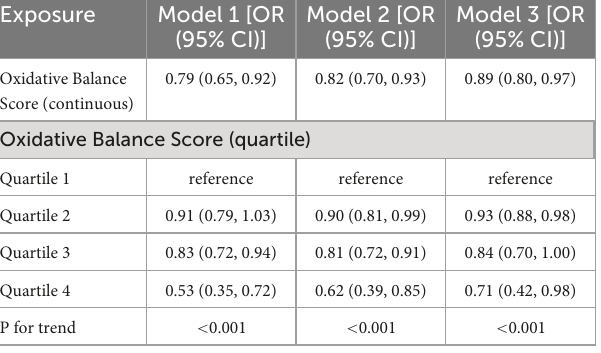
TABLE 3 The associations between Oxidative Balance Score and periodontitis. Exposure Model 1 [OR Model 2 [OR Model 3 [OR (95% CI)] (95% CI)] (95% CI)]